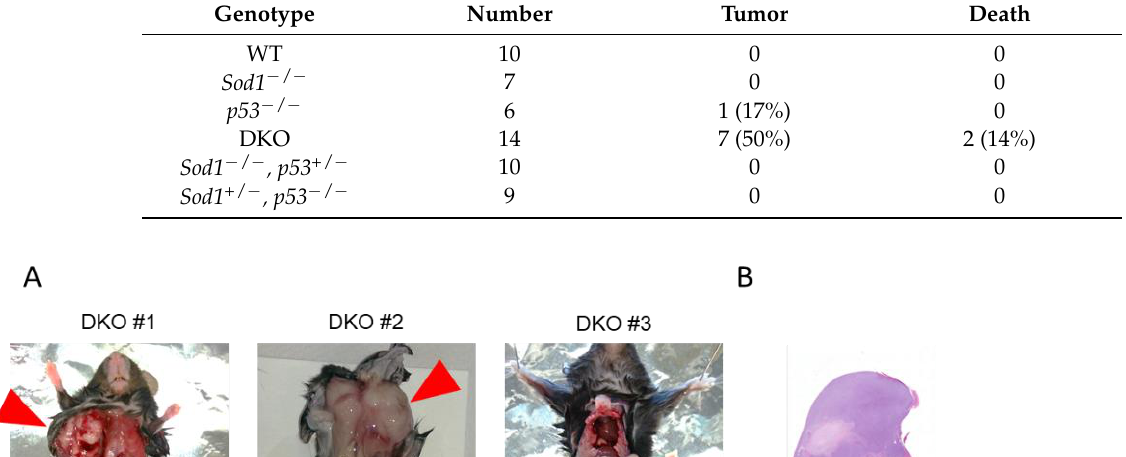
Table 2. The number of tumor or death to each mouse until 4 months of age.